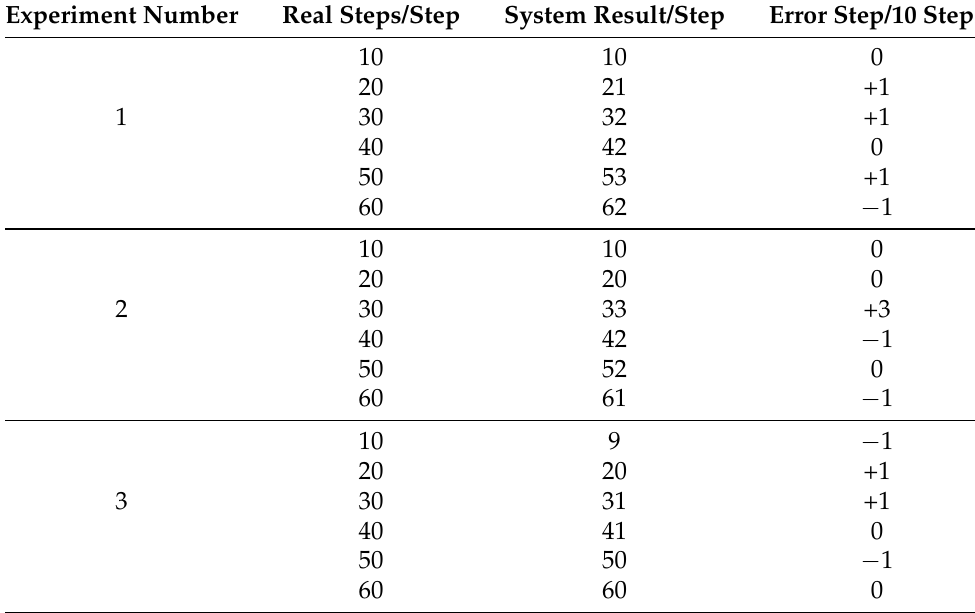
Table 5. Movement steps measurement